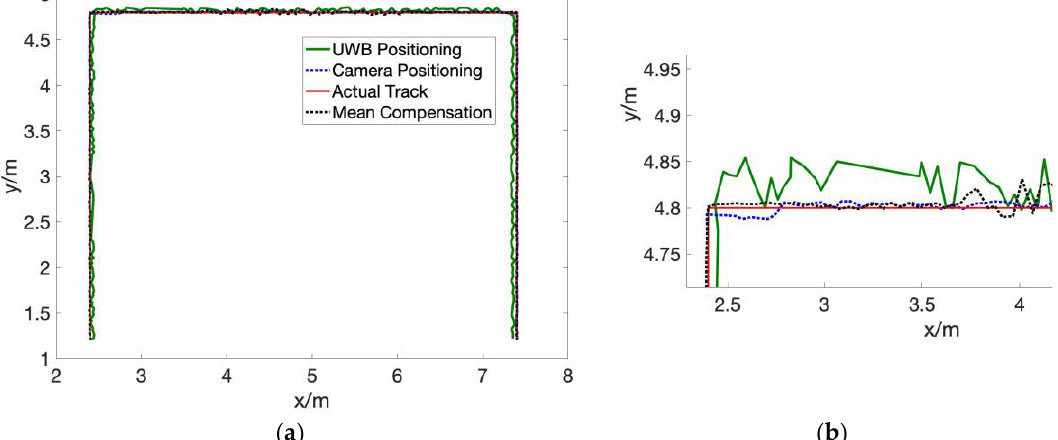
Figure 14. Results of three localization methods: ( a ) relative to the results of the localization of the entire path; ( b ) localization results relative to a path zoom. Table 4. The average errors of 10 fusion localization results on the blocked road.